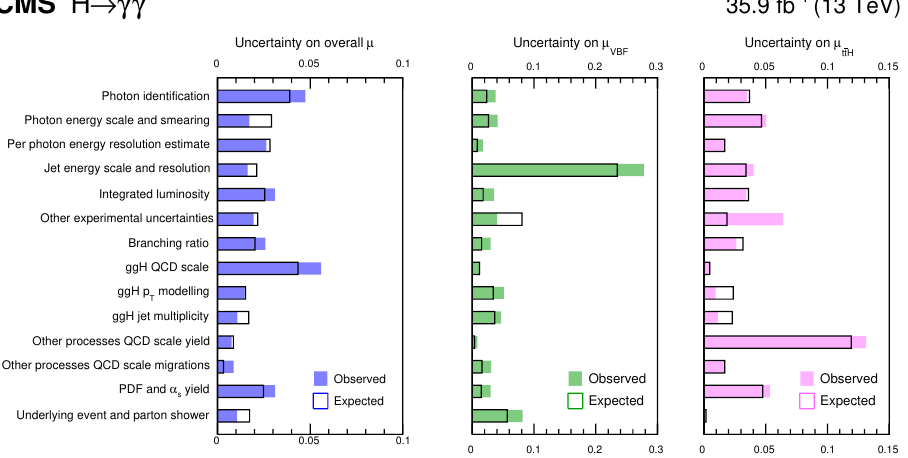
Figure 10 . Summary of the impact of the di(cid:11)erent systematic uncertainties on the overall signal strength modi(cid:12)er and on the signal strength modi(cid:12)ers for the VBF and ttH production processes. The observed (expected) results are shown by the solid (empty)